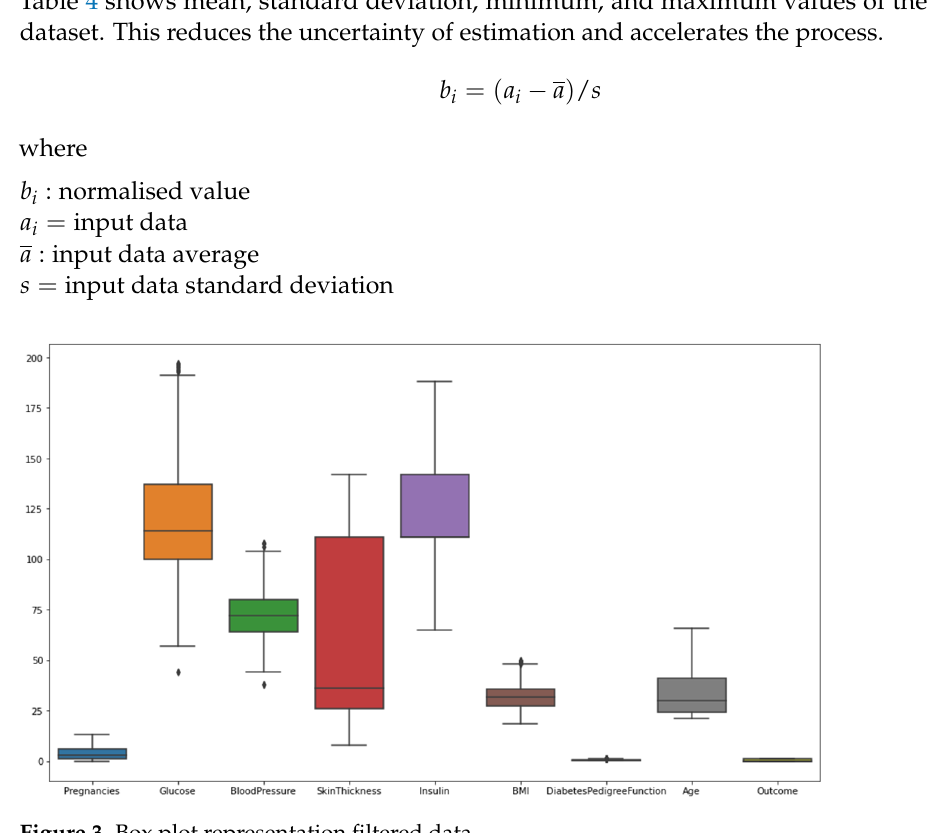
Figure 3. Box plot representation filtered data. Table 4. Statistical analysis of PIMA Indian dataset.